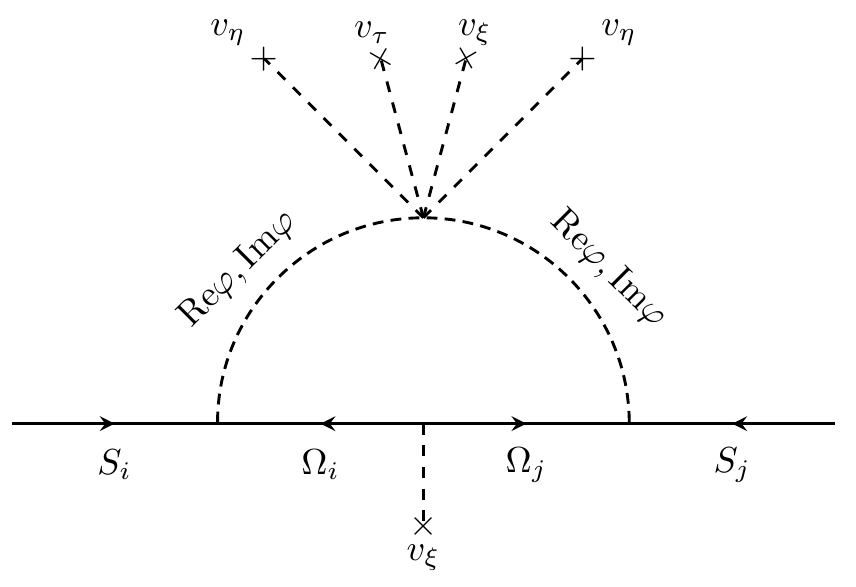
Figure 1 . Loop Feynman diagram contributing to the Majorana neutrino mass submatrix